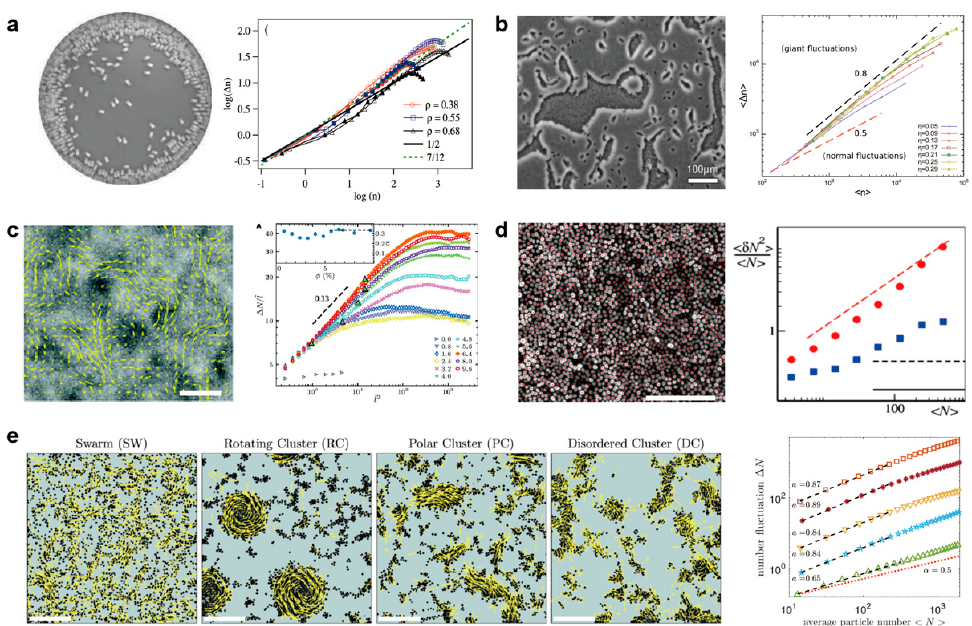
Figure 3. Giant number fluctuation in active matter systems. ( a ) Left: rods migrate and aggregate at the boundaries of a container. Right: the standard deviation of the number of rods ∆ n versus mean number of rods n inside a circular area at the center of the container. Reproduced with permission from [50]. ( b ) Left: M. xanthus bacteria form moving clustering. Right: the number fluctuation of bacterial at relatively high packing fractions. Reproduced with permission from [52]. ( c ) Left: a snapshot of a dense suspension of E.coli bacteria. Right: fluctuation ∆ N / (cid:101) l as a function of (cid:101) l 2 , (cid:101) l = l / l b , where l is the side length of selected area, l b = 3 µ m. The scale bar is 85 µ m. Reproduced with permission from [53]. ( d ) Left: fluorescence microscopy image of monolayer epithelial cell. The scale bar is 0.5 mm. Right: normalized mean squared number fluctuations. Reproduced with permission from [55]. ( e ) Left: collective states formed by Quincke random walkers with different run and turn times: swarming, rotating cluster, polar cluster, and disordered clusters. The scale bar is 1 mm. Right: number fluctuation in different states. Reproduced with permission from